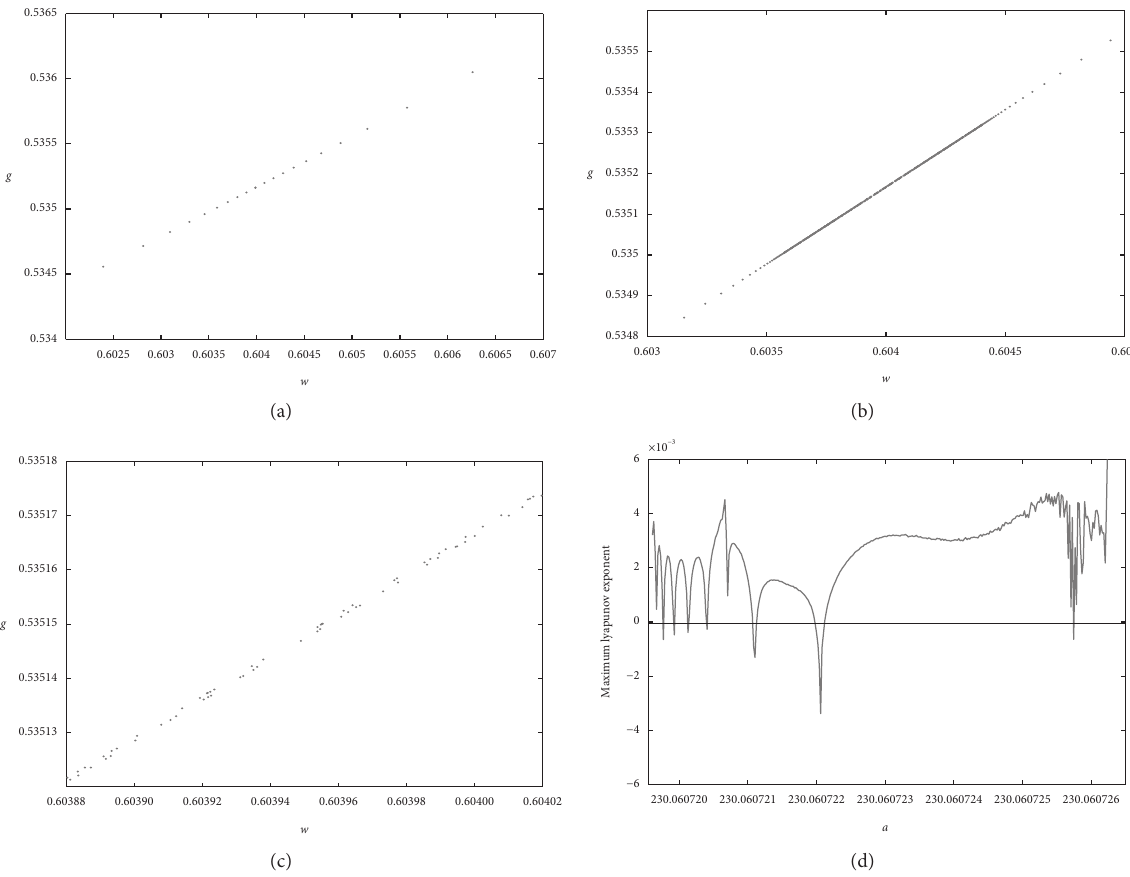
Figure 2: (a) Phase portraits for a � 230 . 060692 and b � 12 . 87486. (b) Phase portraits for a � 230 . 060731 and b � 12 . 87486. (c) Local amplification corresponding to (b). (d) The maximum Lyapunov exponents corresponding to